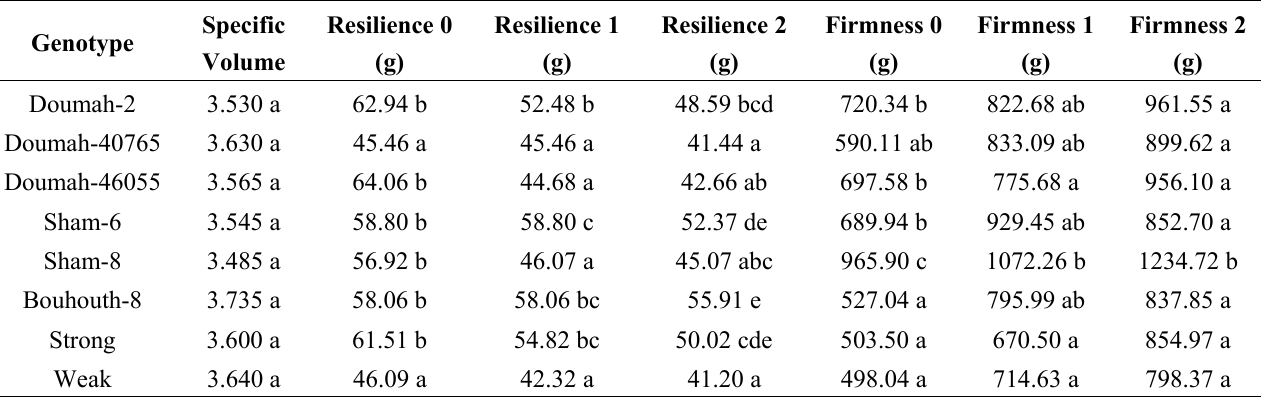
Table 8. Characteristics of the bread